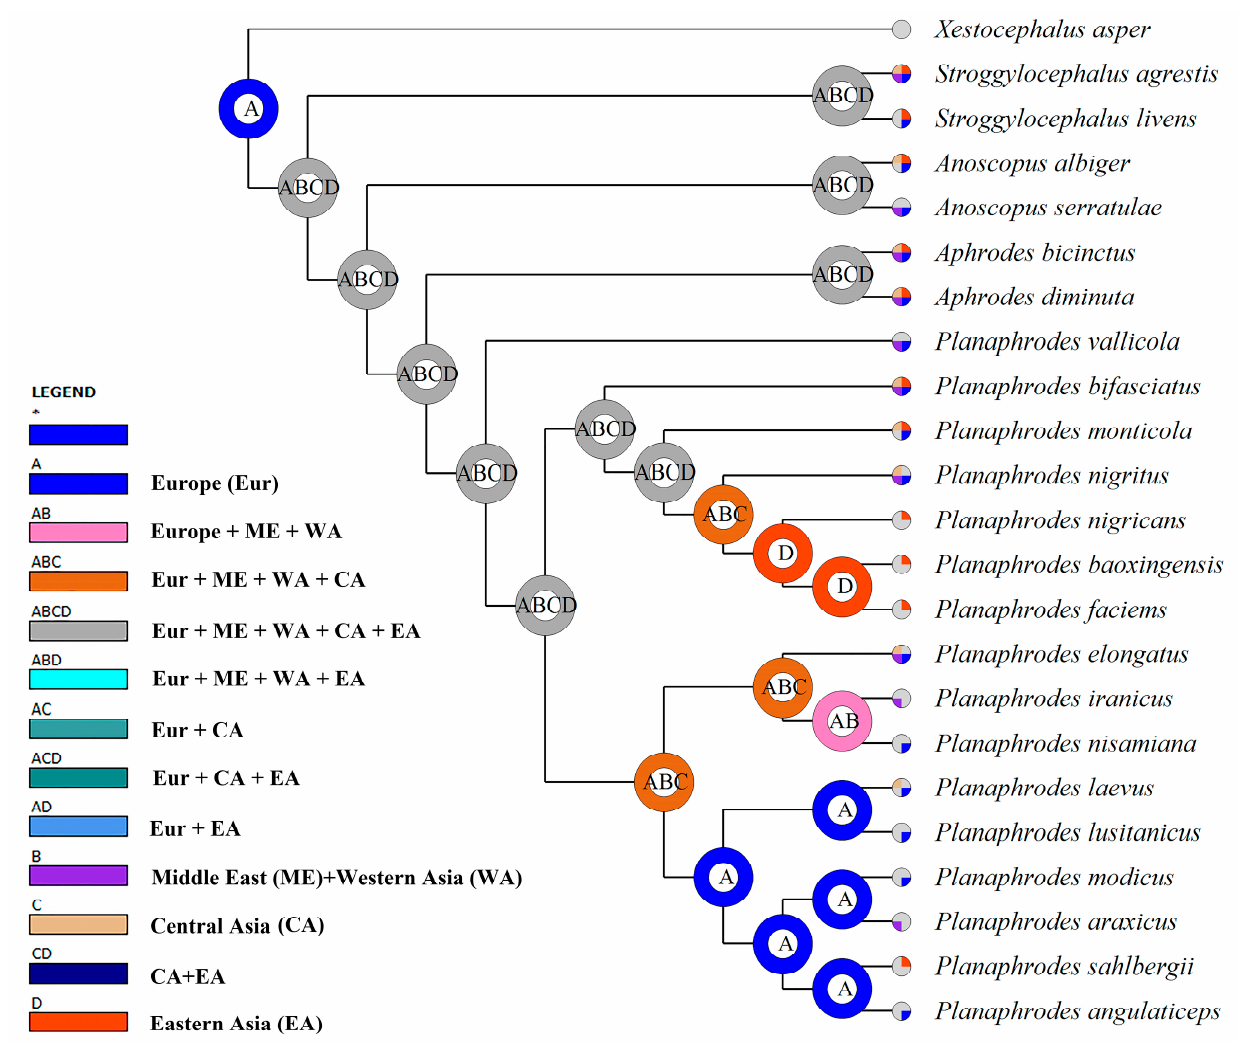
Figure 3. Bayesian binary MCMC reconstruction of biogeographic associations using the consensus of the four original MP trees by TNT.